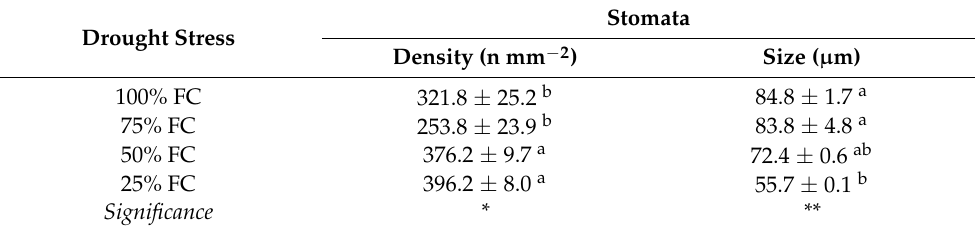
Table 2. Effects of irrigation treatments on stomata density (n mm − 2 ) and size ( µ m) of potted zinnia plants at the end of the experimental period. Plants were irrigated every day. Four treatments were performed: irrigated at 100% (100% FC); light deficit irrigation (75% FC), irrigated at 75% from the 100% FC treatment; medium deficit irrigation (50% FC), irrigated at 50% from the 100% FC treatment and severe deficit irrigation (25% FC), and irrigated at 25% from the 100% FC treatment. Stomata Drought Stress